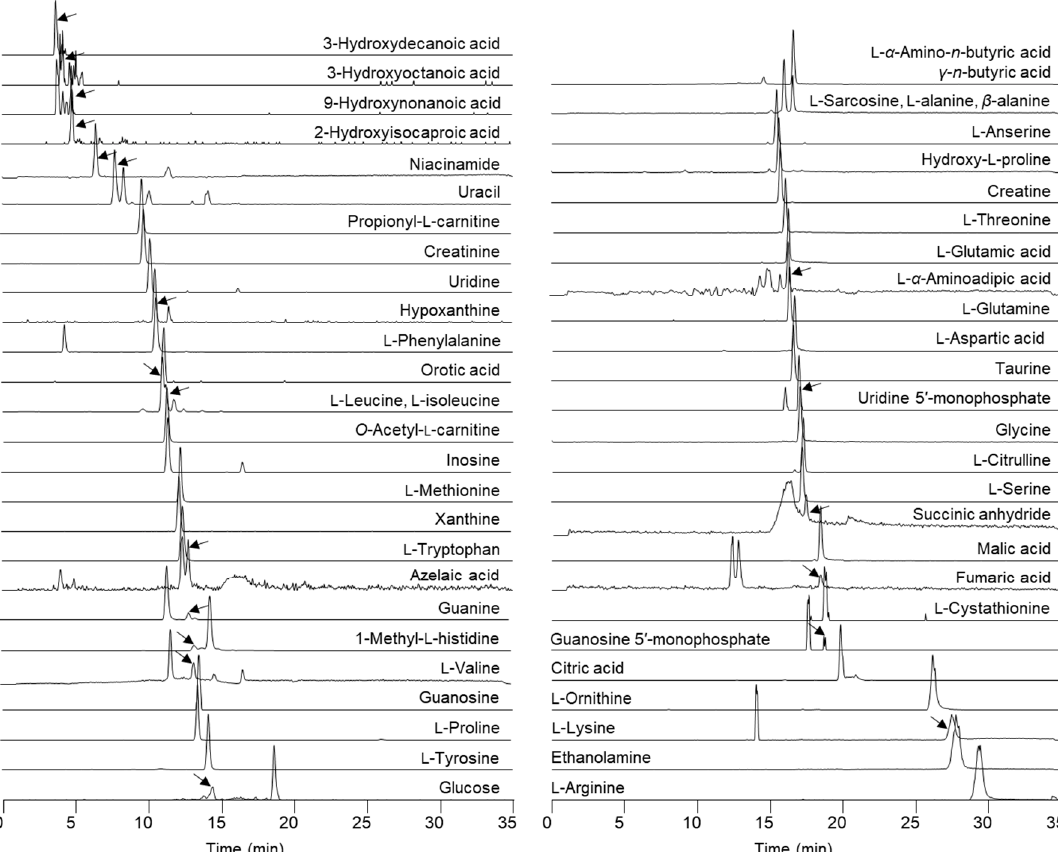
Figure 1. Extracted ion chromatograms from LC–HRMS (±5 ppm) of salmon skin mucus collected using the absorption method. The figure is a collage of ion chromatograms from two different fish. Seven additional metabolites were detected in only few samples and with low signal/noise ratio.